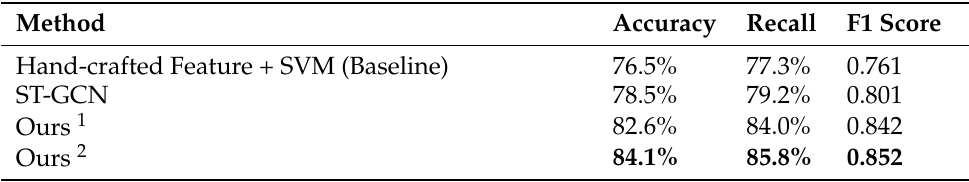
Table 1. Overall performance in accuracy, recall, and F1 score.